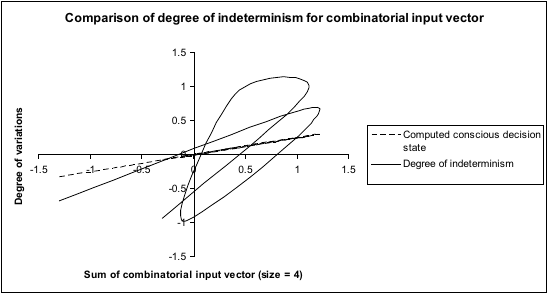
Fig. 15. Variation of state of consciousness in C2 (size = 4).